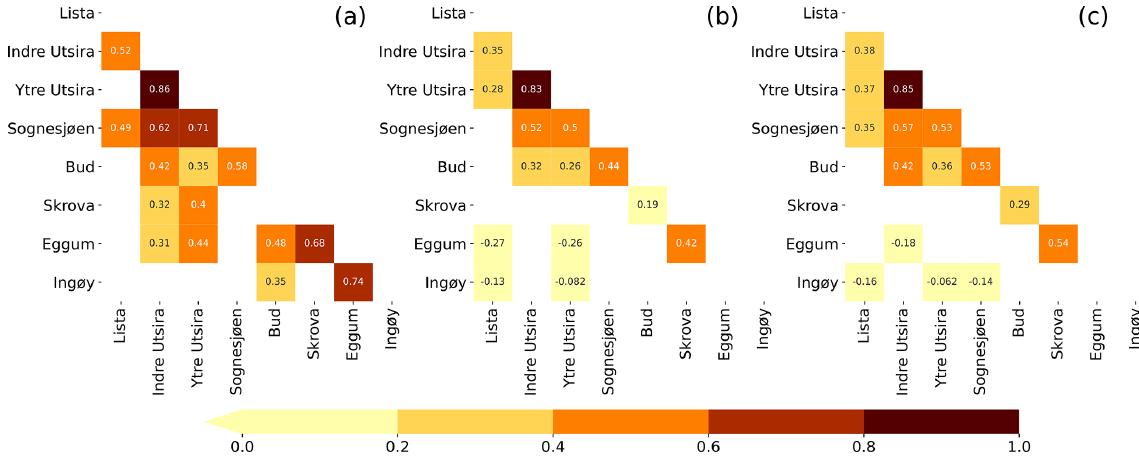
Figure 14. Correlation matrices of the detrended and deseasoned thermosteric (a) , halosteric (b) , and steric (c) components of the sea level at each hydrographic station. Correlation values that are not significant at a 0.05 significance level have been